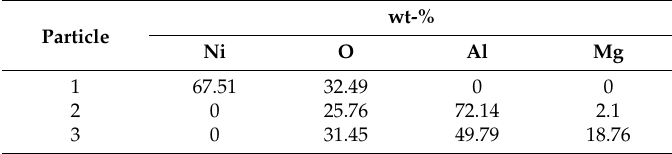
Figure 9. SEM images of the partially reacted NiO particle shown in Figure 8d, and the corresponding EDS patterns of the microareas of the ( 1 ) center, ( 2 ) outside layer, and ( 3 ) MgAl 2 O 4 . Table 5. EDS chemical analysis of the partially reacted NiO particle shown in Figure 8d.